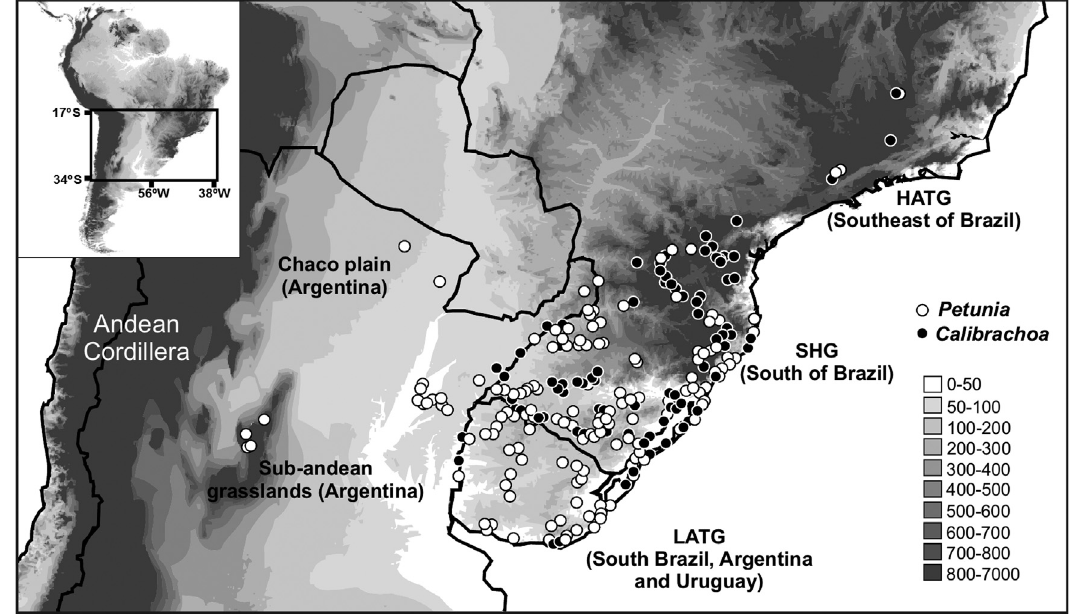
Figure 1 - Geographic distribution of the analyzed samples from both genera throughout eastern South America and across altitudinal gradients. Most of the samples were found in Low Altitude Temperate Grasslands (LATG) and Subtropical Highland Grasslands (SHG). Occurrences in High Altitude Tropical Grasslands (HATG) are also indicated, as well as a few records for the Sub-Andean grasslands and Chaco plain vegetation (at left). Shading ranging from white to dark gray represents elevation above the sea level as estimated in